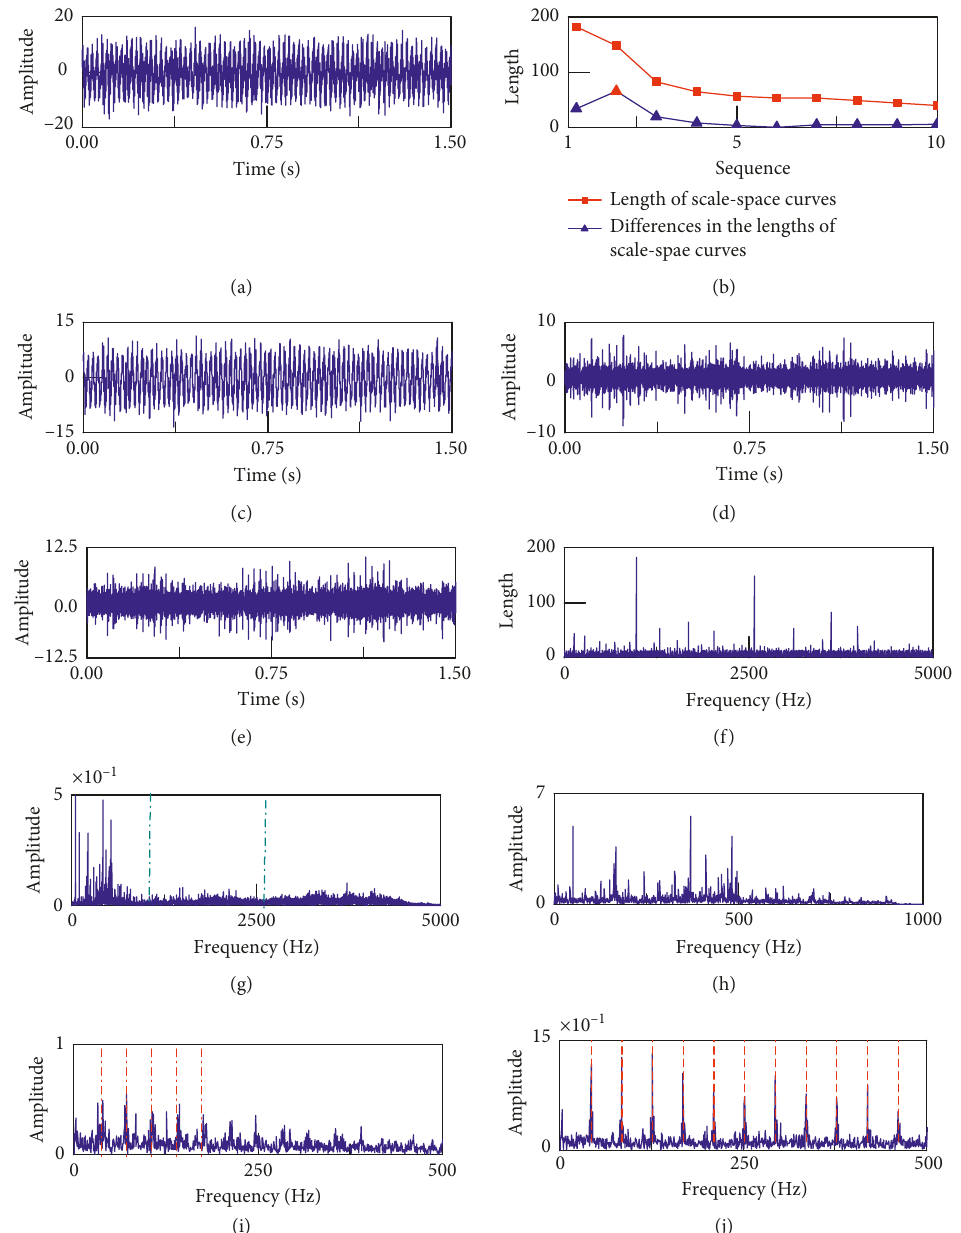
Figure 25: Results obtained by the EWTOSSR: (a) measured signal; (b) differences in the lengths of scale-space curves; (c–e) sub-band signals; (f) OSSP; (g) detected boundaries (green dash-dotted lines); (h–j) squared envelope spectra (red dashed lines: f BPFO and its harmonics; red dash-dotted lines: f BSF and its